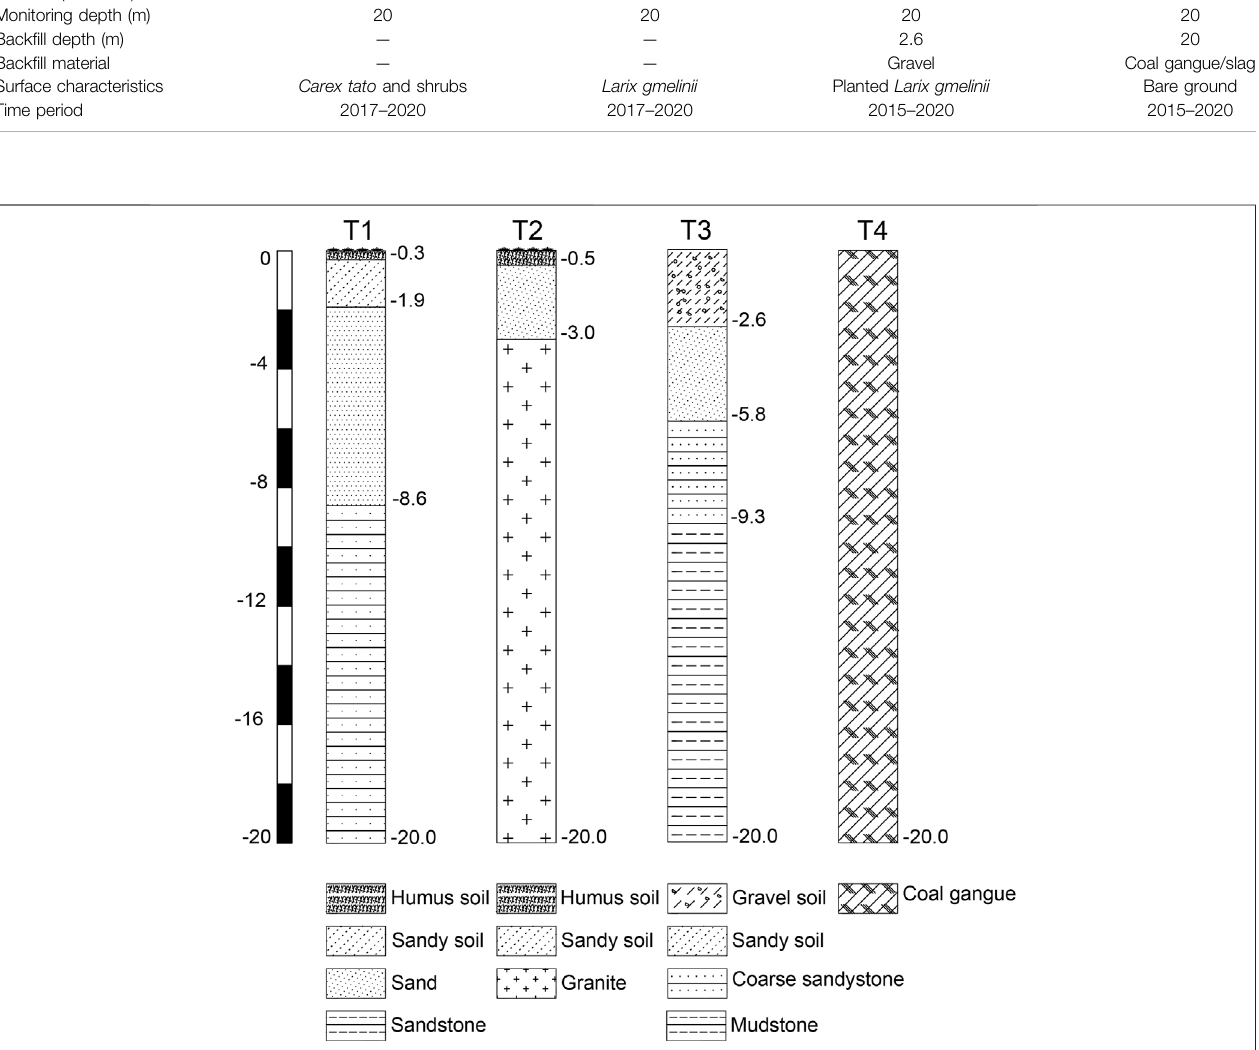
Frontiers in Earth Science |